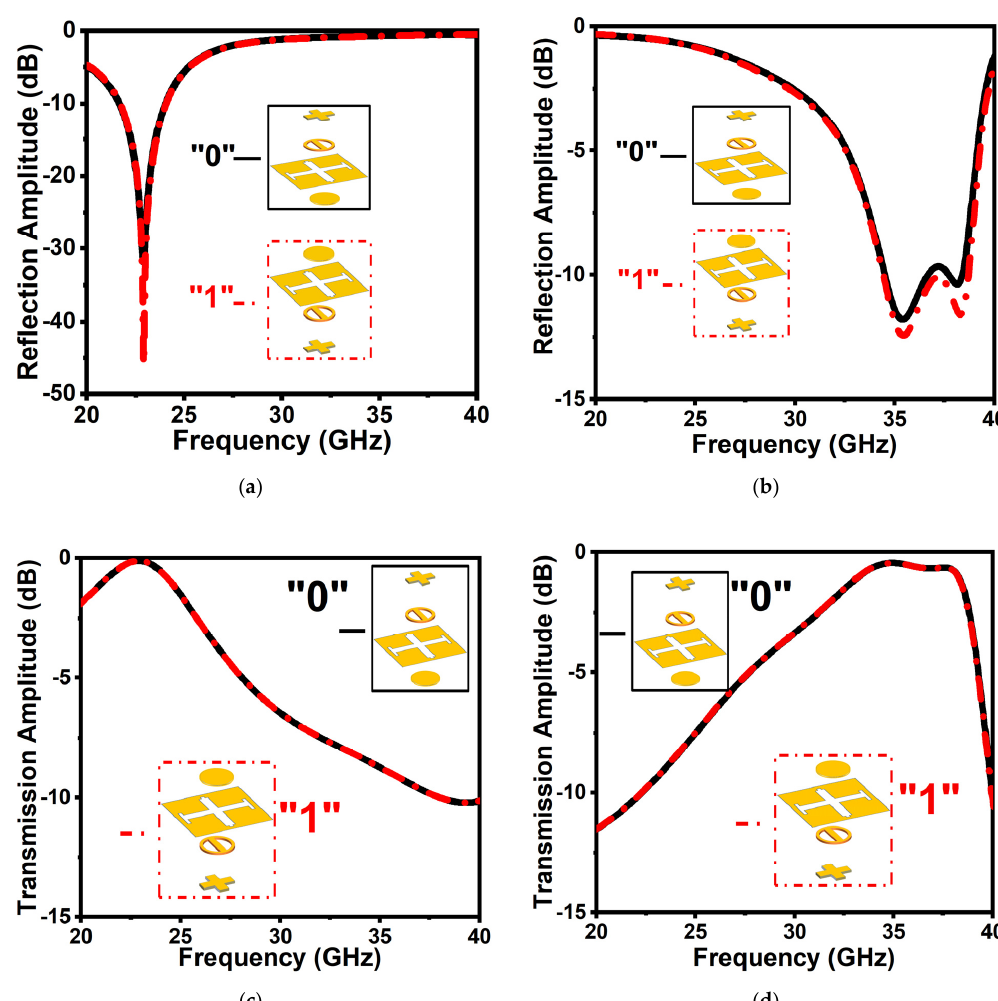
Figure 4. Amplitude of the elements “0” and “1” for reflection: ( a ) TE wave; ( b ) TM wave. Transmission amplitude of ( c ) TE and ( d ) TM waves, respectively.